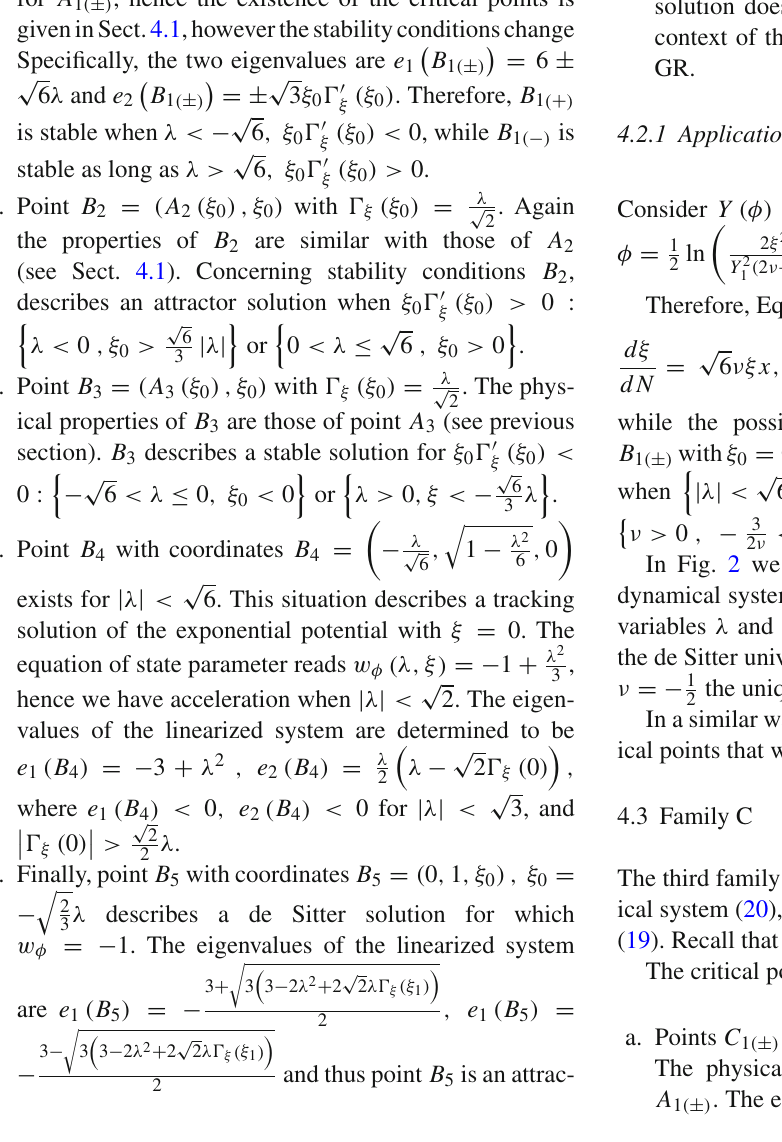
Fig. 2 Phase space portrait in the variables { x ,ξ } for the dynamical system (20), (21) and (23) and for (cid:2) (cid:3) ν + λ φ 2 Y (φ) = Y 1 e without a matter source. Left-hand figure is for λ = − 2 and ν = 1 where we see that point B 5 is the attractor of the system. \ Right-hand figure is for −√ λ = 3 and ν = − 1 where 2 the attractor is point B 4 ,which describes the tracking